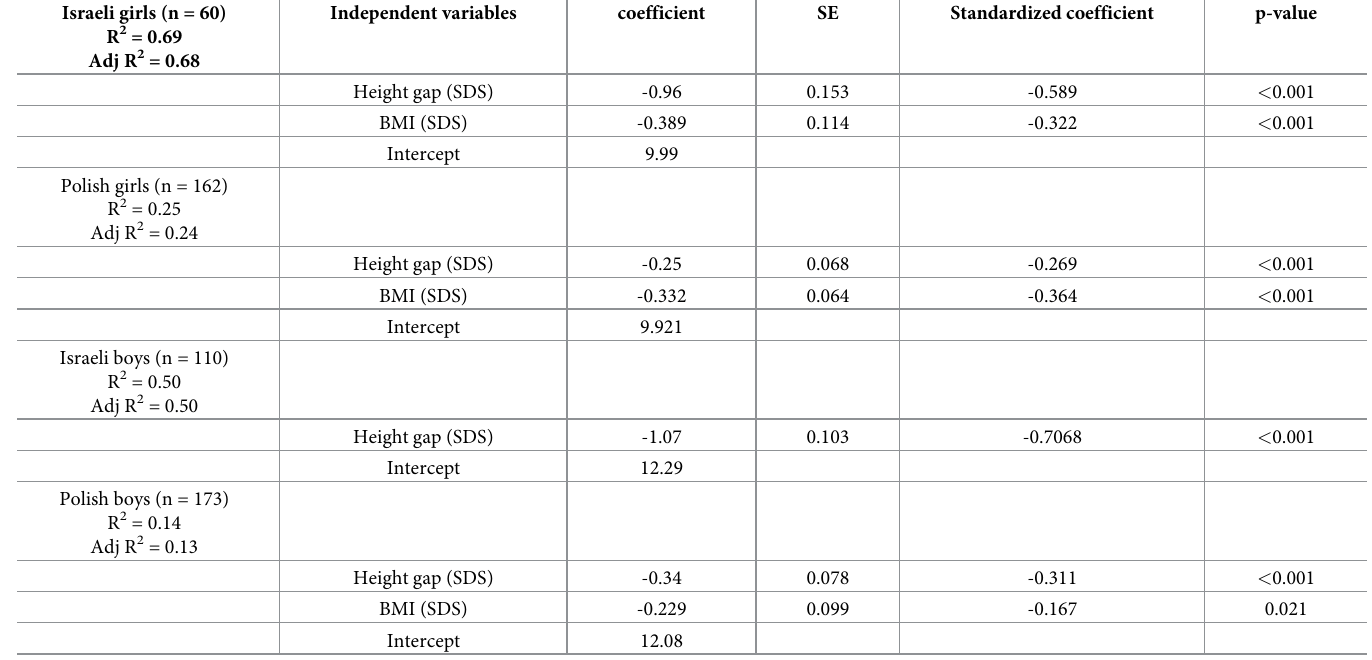
In all groups except for the group of Polish girls, using height-SDS of the child resulted in lower correlation than that obtained by height gap. Specifically, the value of the adjusted Table 3. Results of the regression analysis of the onset age of puberty with the height gap and the BMI-SDS. Israeli girls (n = 60) R 2 = 0.69 Adj R 2 =